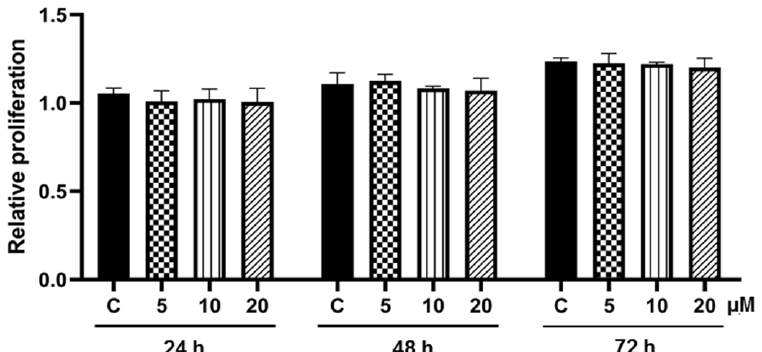
Figure 4. Effect of pinostrobin on mitotic clonal expansion in pre-adipocyte 3T3-L1 cells. Crystal violet assay was performed after 24–72 h cultured with differentiation medium with or without 5–20 µ M pinostrobin. Cell proliferation was presented relative to the vehicle control cells (C) treated with 0.5% DMSO for 24